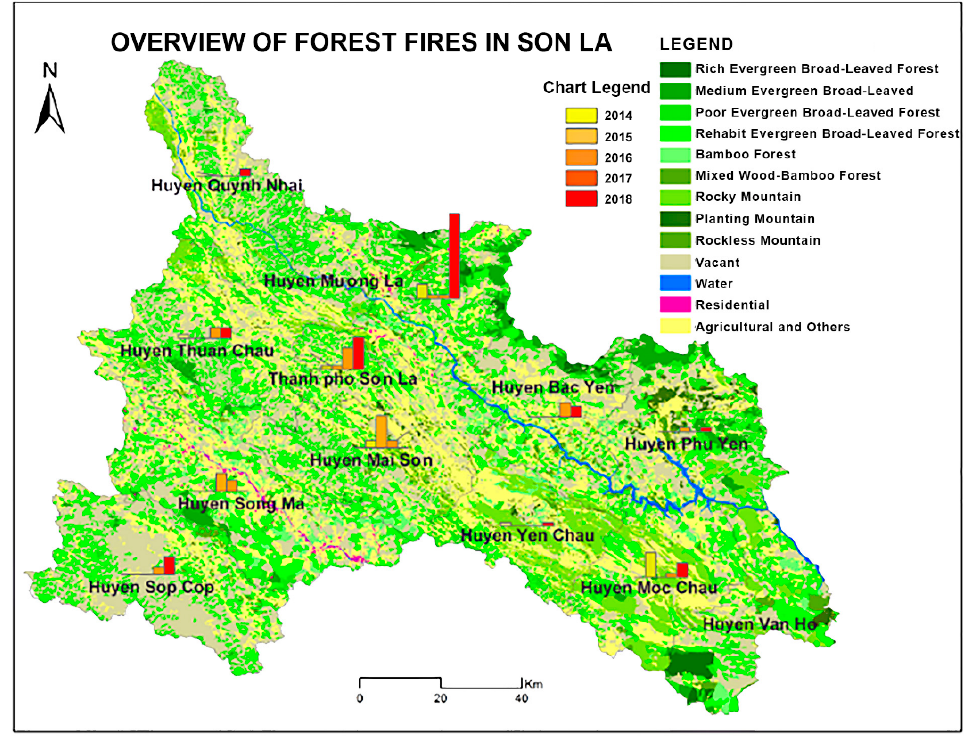
Figure 3. Map of the forest fires in Son La (2014–2018).